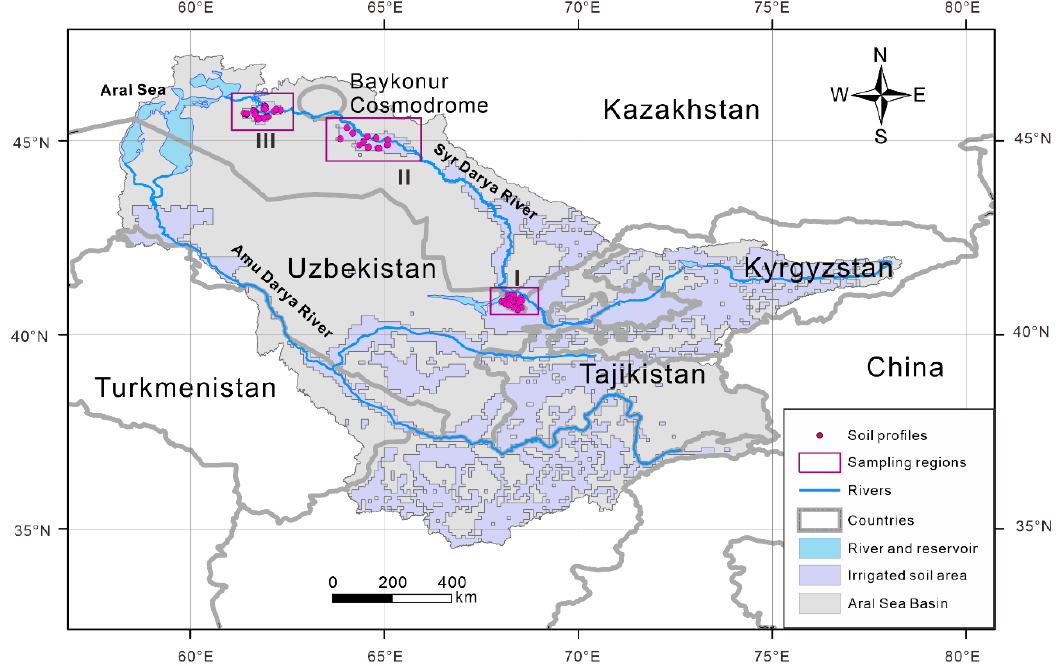
Figure 1. Locations of the study regions (I, II, and III) and distributions of the soil sampling profiles (I: n = 29; II: n = 17; III: n = 29). The boundaries of the irrigation areas are from the literature [31]. The geographical coordinates of the soil profiles are shown in Table S1 in the supplementary file.